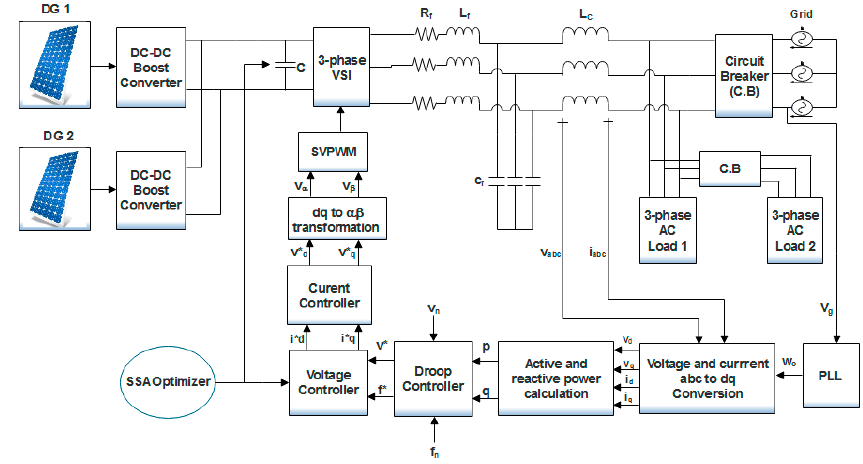
Figure 3. Studied islanded MG with power and control architecture.